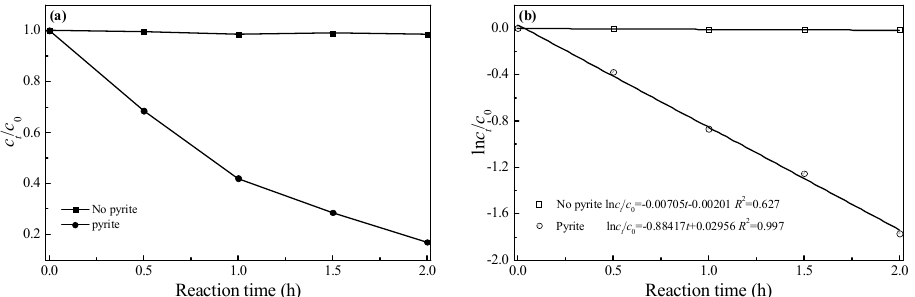
Figure 2. ( a ) Reactions of pyrite catalyzed detoxification of CYN and control. ( b ) Reaction kinetics of CYN detoxification, assuming pseudo-first order kinetics. CYN concentration = 2 mg/L; pyrite dose = 0.5 g/L; no pH adjustment.